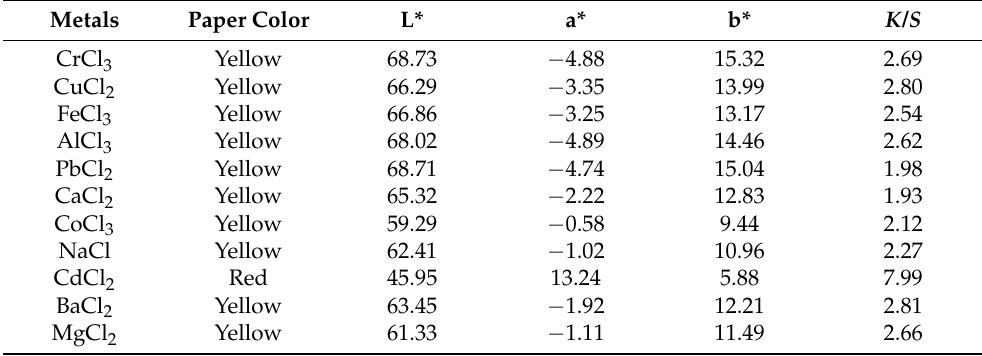
Table 4. Colorimetric parameters of paper test sensor for various metal ions (250